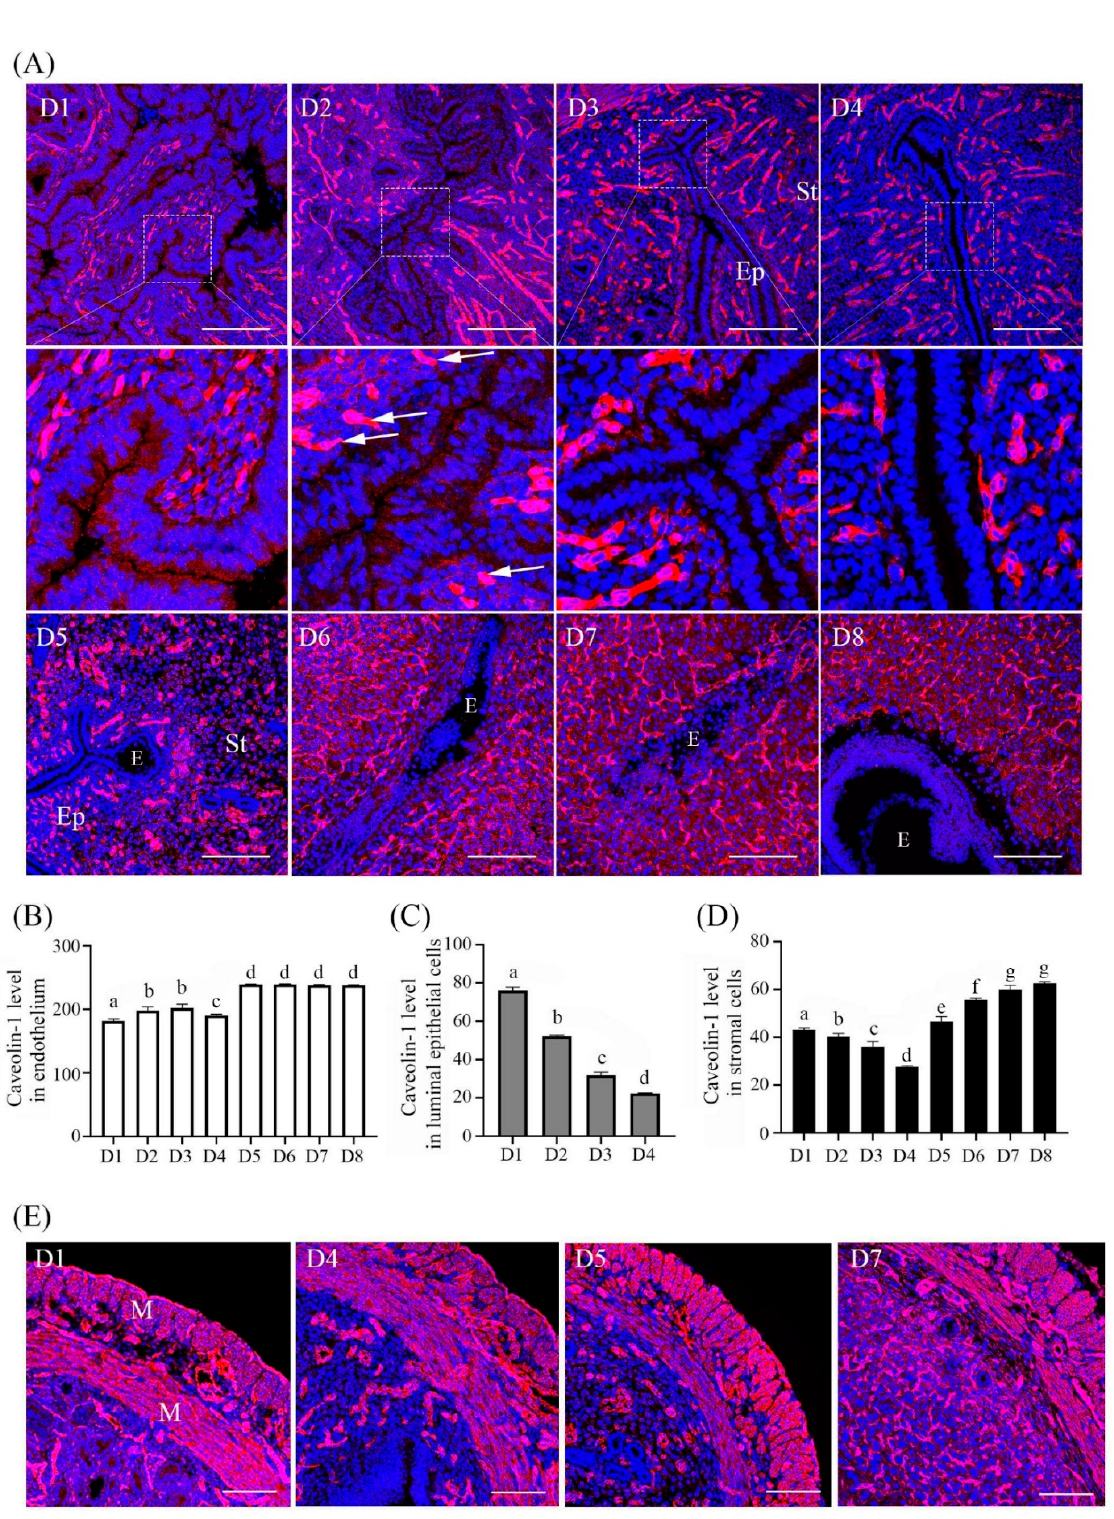
Figure 1. Caveolin-1 immunofluorescence in mouse uteri during early pregnancy. ( A ) Caveolin-1 immunofluorescence in mouse uteri from days 1 to 8. ( B ) Semi-quantitative Caveolin-1 level in endothelium. ( C ) Semi-quantitative Caveolin-1 level in luminal epithelial cells. ( D ) Semi-quantitative Caveolin-1 level in endometrial stromal cells. ( E ) Caveolin-1 immunofluorescence in mouse myometrium. Five mice per group. E, embryo; White arrow, endothelium; St, stromal cells; Ep, epithelium; M, muscle. Different letters on each bar show significant difference between two groups. Scale bar = 200 μ m.